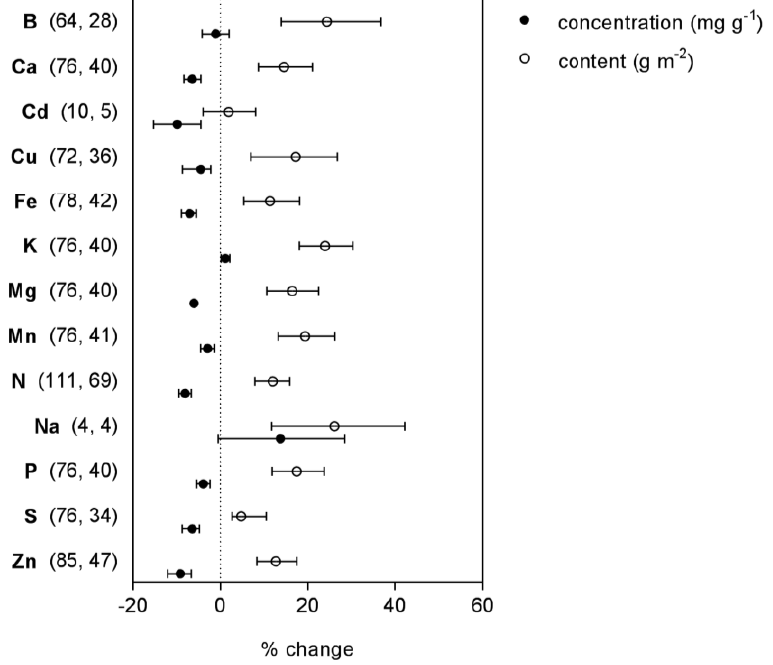
Figure 4. Meta-analysis output for mineral concentration and content using ambient CO 2 as the reference. Numbers within brackets gives the number of comparisons for the concentration and content, respectively.